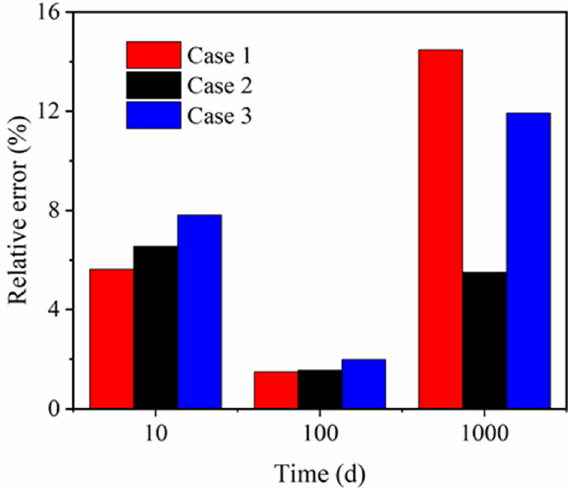
Figure 3. Relative error between the values predicted by MLP networks and true values under dif- ferent production